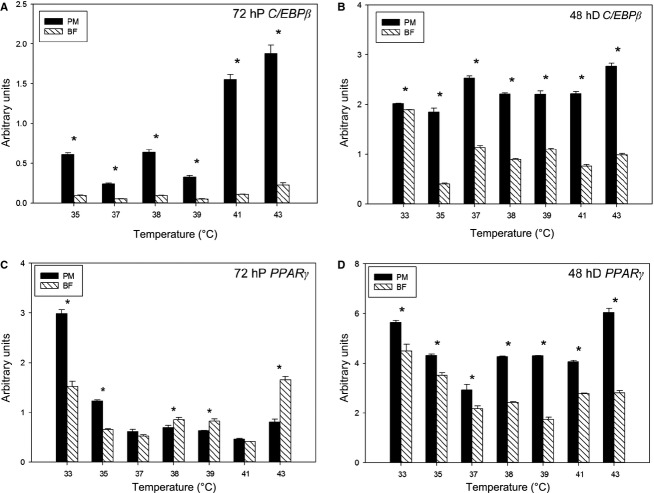
Expression of adipogenic genes CCAAT/enhancer-binding protein β and peroxisome proliferator-activated receptor gamma in pectoralis major and biceps femoris satellite cells at different temperatures during proliferation and differentiation. The expression of CCAAT/enhancer-binding protein β (C/EBPβ) at (A) 72 h of proliferation and (B) 48 h of differentiation, and peroxisome proliferator-activated receptor gamma (PPARγ) at (C) 72 h of proliferation, and (D) 48 h of differentiation by real-time quantitative PCR. Bars represent standard error of the mean. PM, pectoralis major; BF, biceps femoris. 72 hP, 72 h of proliferation; 48 h D, 48 h of differentiation. Data with *indicate significant difference between cell fiber types (P ≤ 0.05) at individual temperatures.